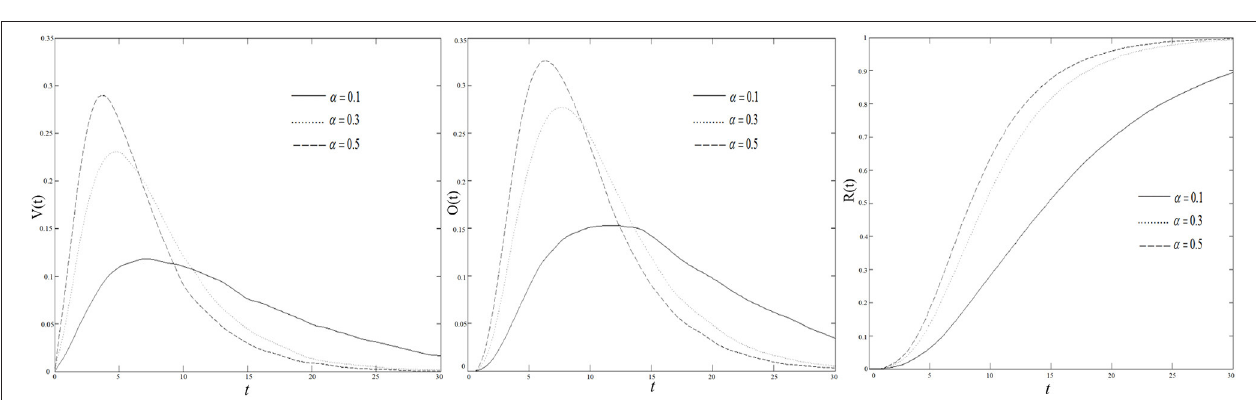
FIGURE 11 | The density of variation, oyster, and recovery vary with alpha in BA scale-free